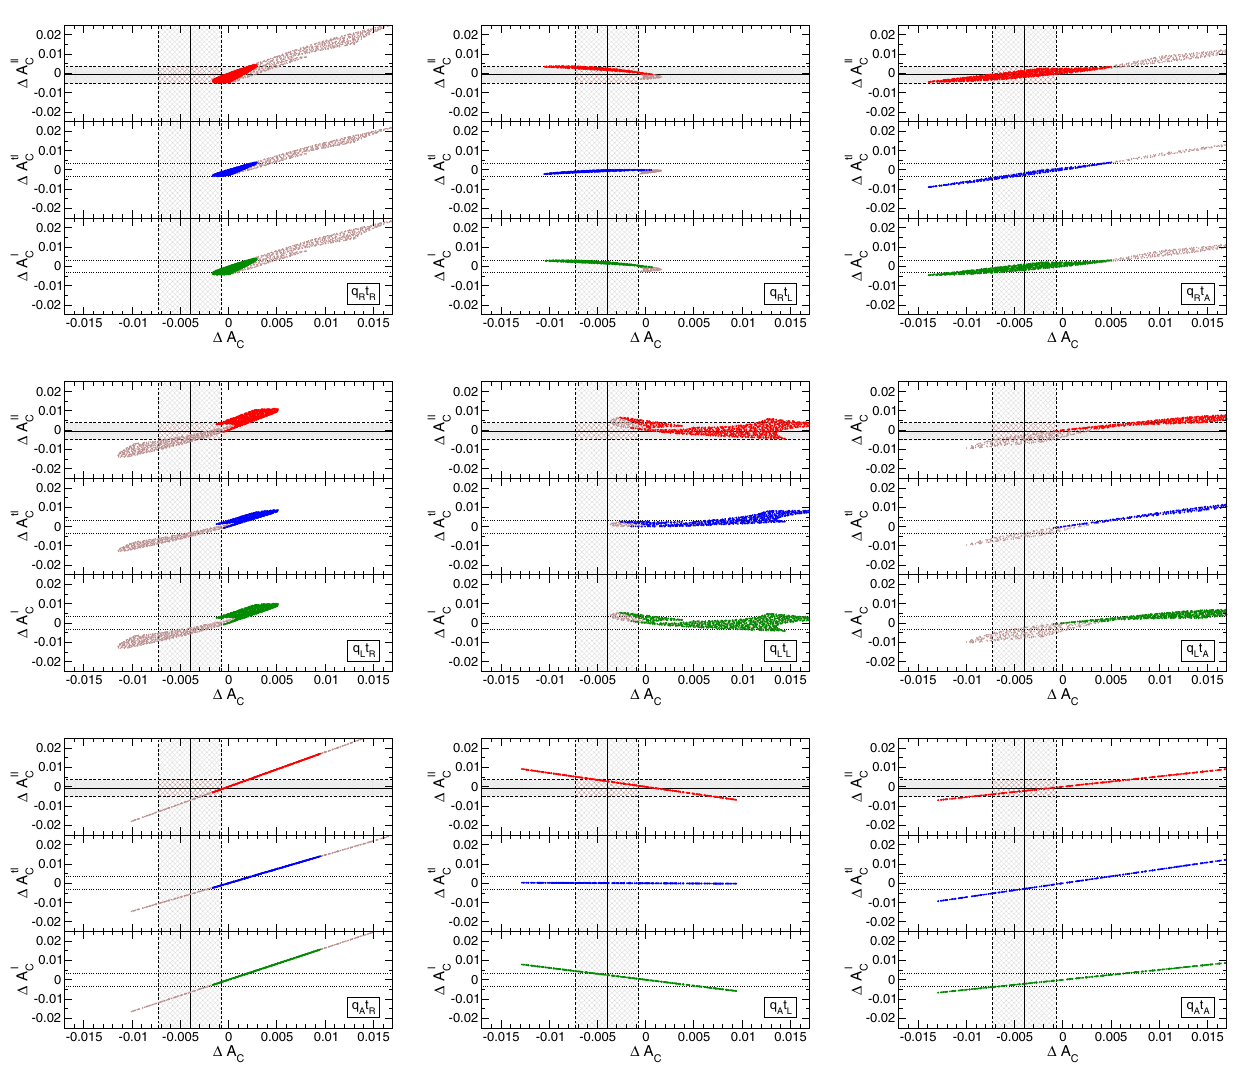
Fig. 3 Allowed range for the new physics contributions to A (cid:3)(cid:3) benchmarks considered. The coloured regions include the constraint from P z , while the gray regions do not. The CM energy is 8 TeV